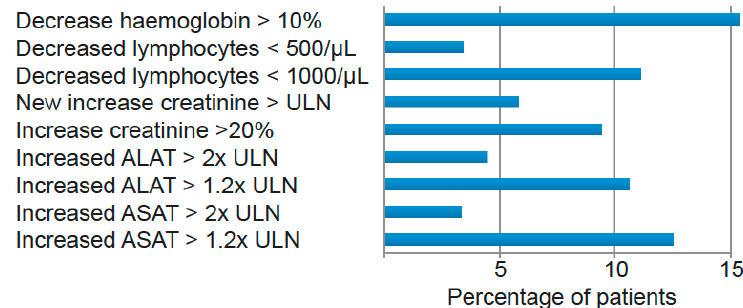
Figure 4. Patients were followed for laboratory changes under treatment with tofacitinib. Data are shown for patients with at least one in- or decrease in one of these parameters during follow-up. Percentages were calculated on patients with available data. ALAT: alanine amino transferase. ASAT: aspartate amino